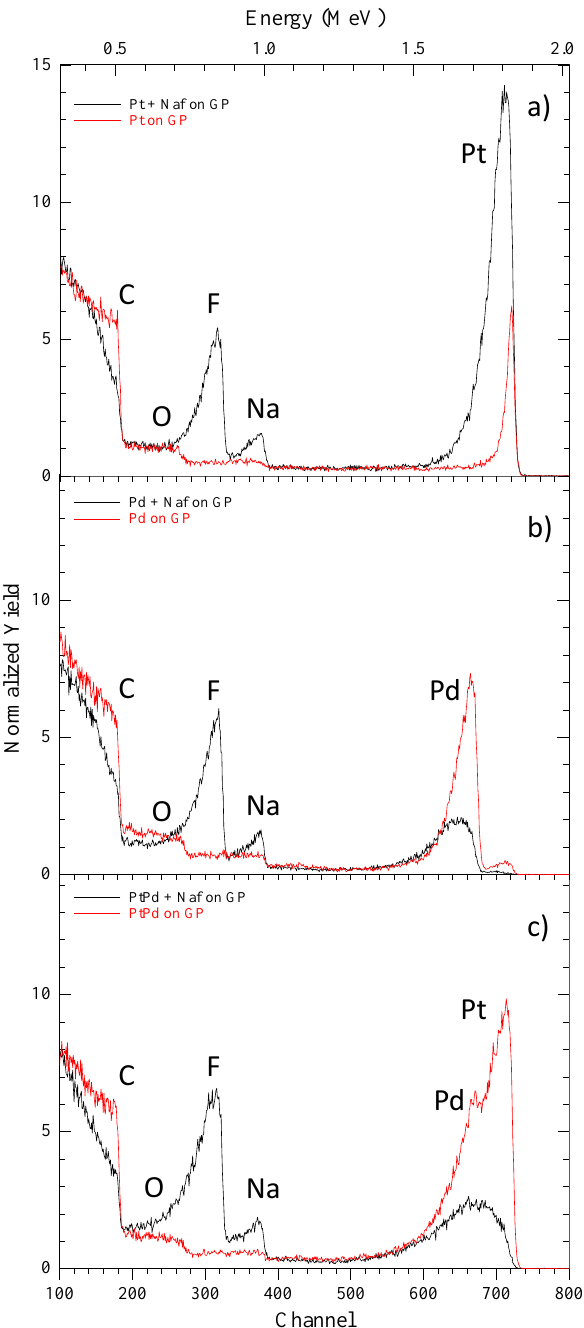
Figure 3. Rutherford backscattering spectra of NPs-GP composite systems obtained by water (red lines) and water-0.25% wt. Nafion suspensions (black lines): ( a ) Pt; ( b ) Pd; ( c ) Pt 80 Pd 20 .